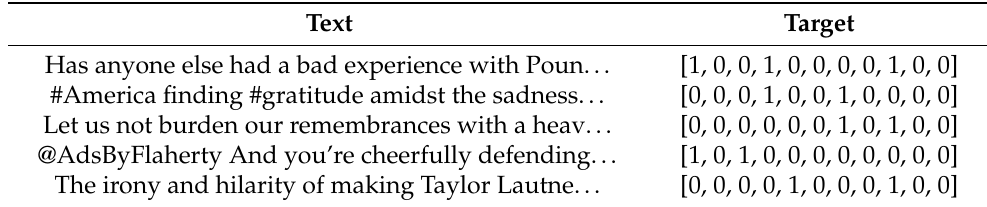
Table 1. Examples of tagged text in the dataset. Text Target